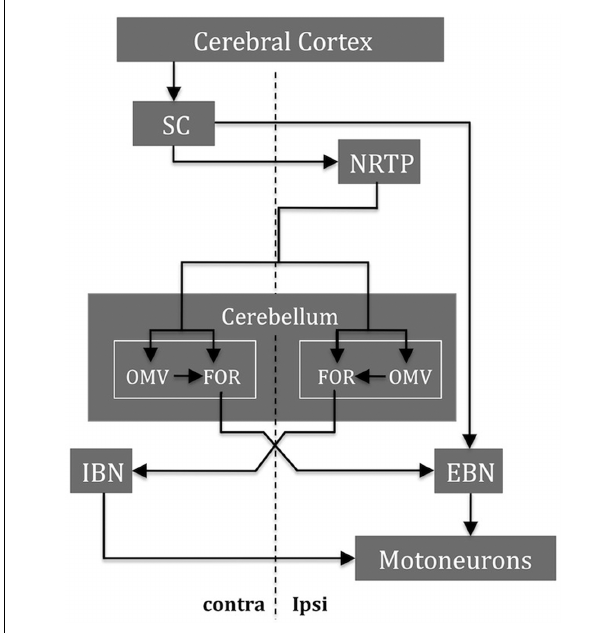
FIGURE 5 | Some major structures and their main connections are shown for saccade control in one direction. During the saccade, the cerebellum integrates the efference copy of the drive signal from the NRTP (ipsilateral to the movement) that projects bilaterally to both OMV and FOR within the cerebellum.The SC and the FOR (both contralateral to the movement) excite the EBN that contact the motoneurons (both ipsilateral to the movement) of the agonist muscle.When the eyes approach the target, the ipsilateral FOR neurons produce a choke signal through the contralateral IBN that inhibits the motoneurons of the agonist muscle. NRTP, nucleus reticularis tegmenti pontis; DLPN, dorsolateral pontine nuclei; OMV, oculomotor vermis; FOR, fastigial oculomotor region; SC, superior colliculus; EBN, excitatory burst neurons; IBN, inhibitory burst neurons (modified after Quaia et al.,